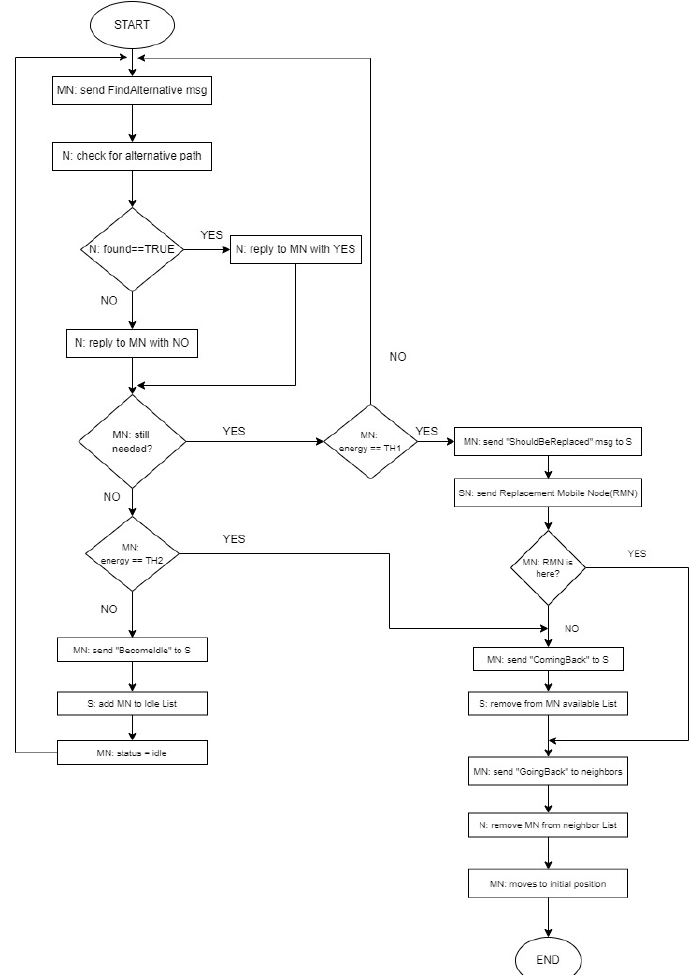
Figure A3. Energy Node Placement Algorithm